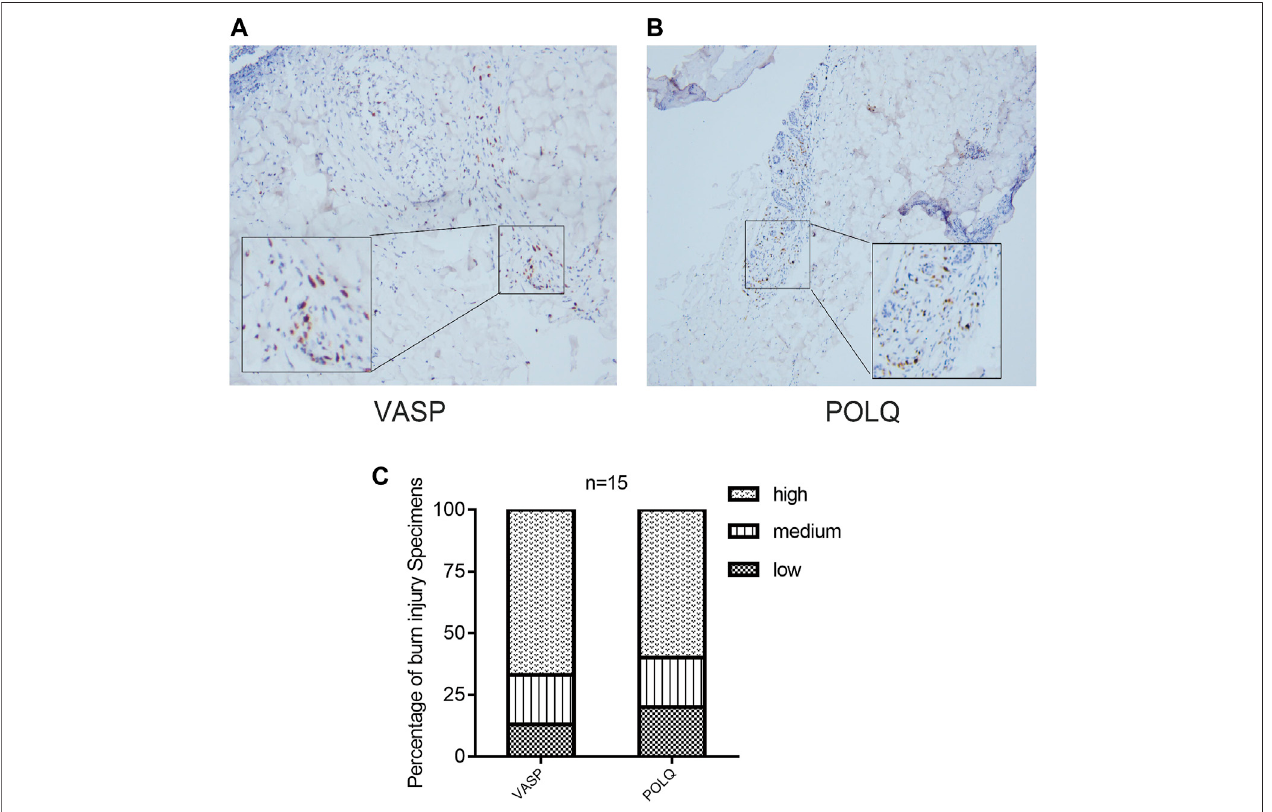
FIGURE 10 | Immunohistochemistry staining and histologic scoring. IHC staining demonstrated that VASP (A) and POLQ (B) showed high expression; (C) results of histologic scoring and analysis.